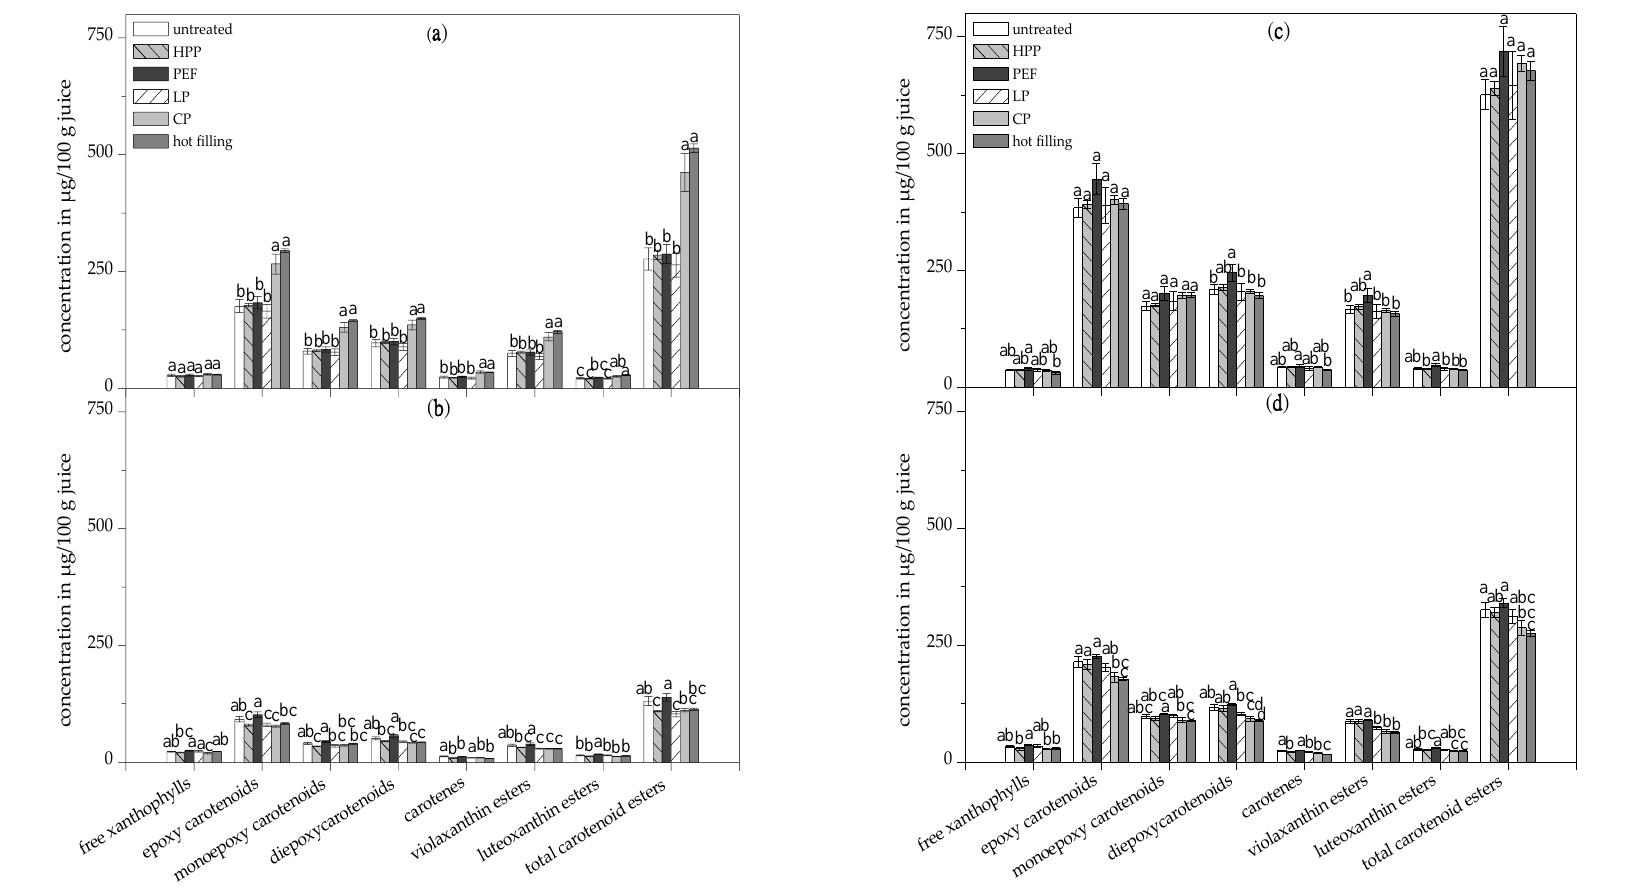
Figure 4. Concentrations of several carotenoid groups in the soluble ( a ) and micellar fractions ( b ) of the untreated and pasteurized orange juices without ultrasonication, and in the soluble ( c ) and micellar fractions ( d ) of the ultrasonicated juices. Different letters indicate significant differences ( p ≤ 0.05). Values are means ± standard deviation (n = 3).